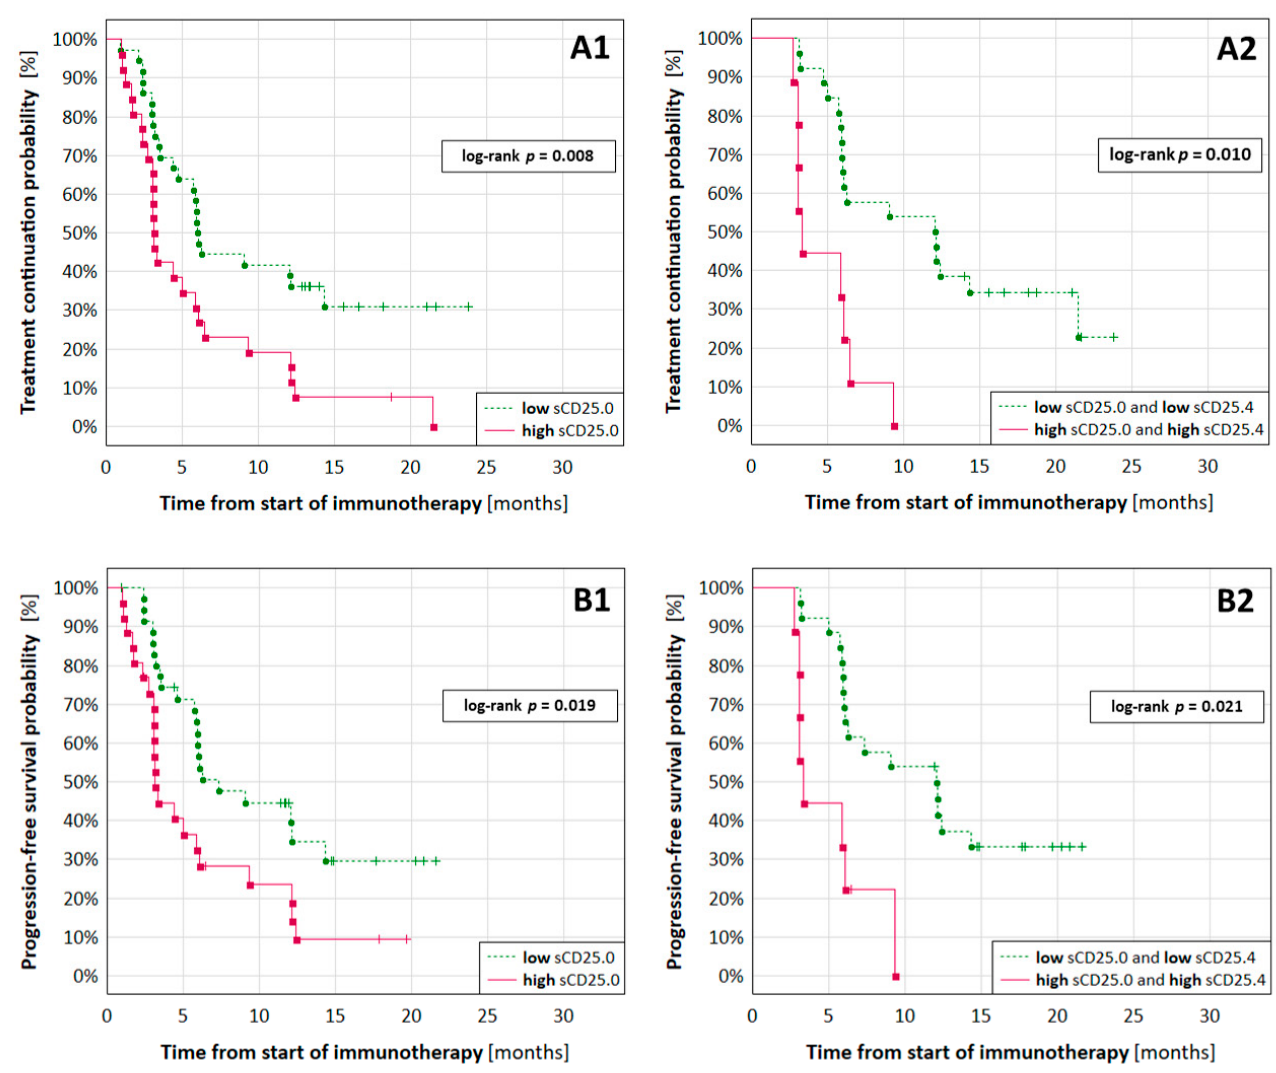
Figure 3. Kaplan–Meier curves for TTF and PFS based on the sCD25 levels. High sCD25.0 level ( ≥ 5.99 ng/mL) was a prognostic factor of ( A1 ) shorter TTF and ( B1 ) shorter PFS; high sCD25.0 ( ≥ 5.99 ng/mL) and sCD25.4 ( ≥ 7.73 ng/mL) levels were a prognostic factor of ( A2 ) shorter TTF and ( B2 ) shorter PFS in NSCLC patients dosed with ATEZO or PEMBRO; complete observations are denoted as filled circles, censored observations as